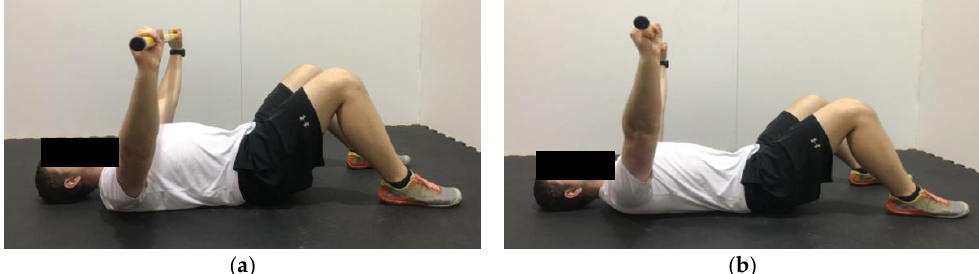
Figure 8. Demonstration of serratus push in the ( a ) start position; ( b ) end position. Hold the bar further than shoulder width. The goal is to avoid excessive horizontal adduction, while keeping the arms straight and pushing the bar